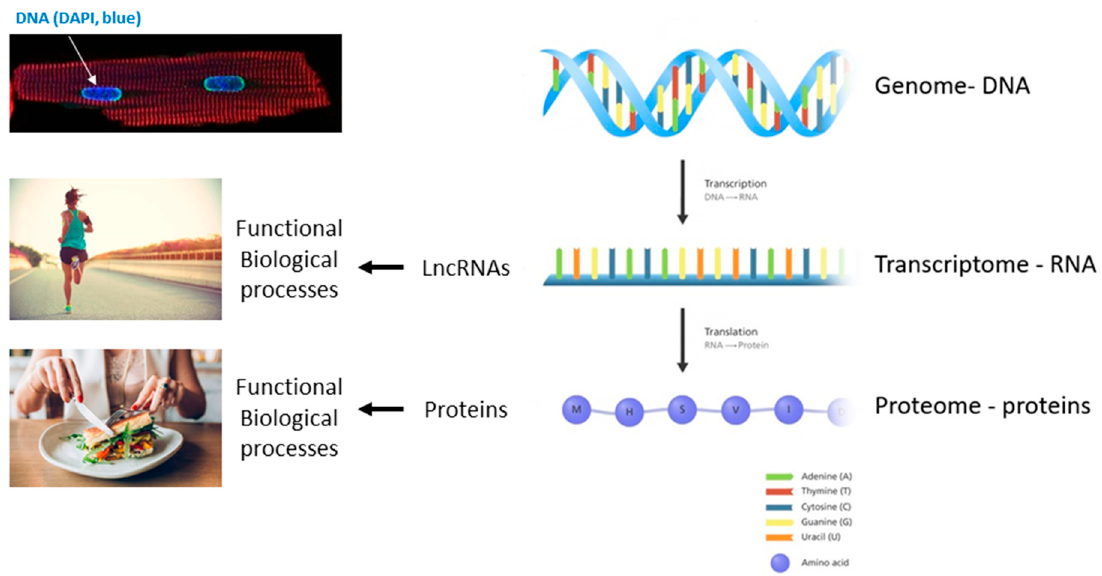
Figure 1. The revised central dogma in molecular biology. Image credit: this figure is adapted from Genome Research Limited.